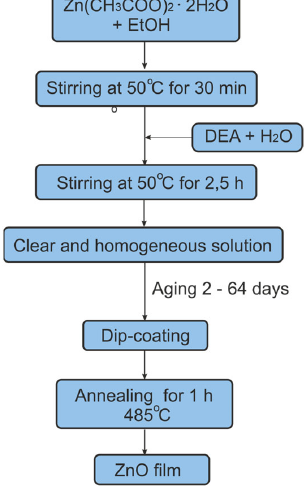
Figure 1. The course of the procedure for producing thin ZnO